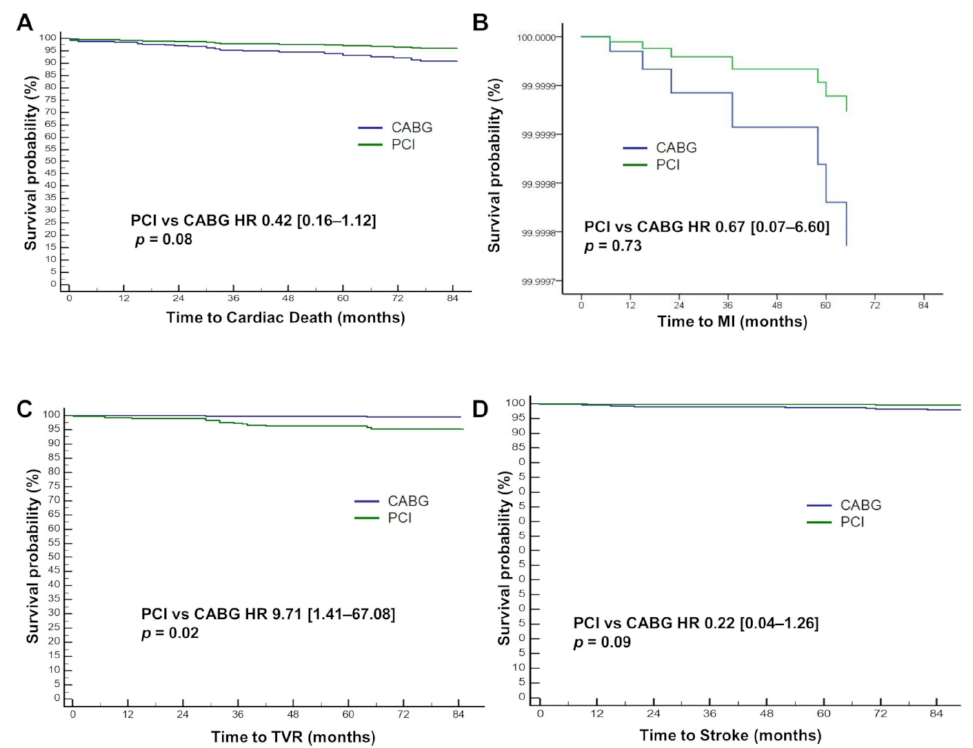
Figure 5. Multivariate-adjusted survival plot of clinical endpoints. Multivariate Cox regression plots of ( A ) cardiac death, ( B ) myocardial infarction (MI), ( C ) target vessel revascularization (TVR), and ( D ) stroke are shown. Adjusted for age ≥ 65, sex, HTN, ACS, CKD, CTO, DM, EF, EuroSCORE II, HTN, presence of high SYNTAX scores group, syntax score of LM, distal LM bifurcation, isolated LM disease. CABG, coronary artery bypass graft; PCI, percutaneous coronary intervention; HR, hazard ratio. All other abbreviations are listed in Tables 1 and